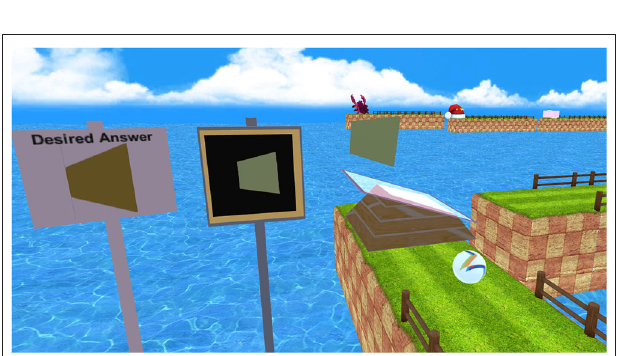
FIGURE 6 | A puzzle from the game featuring a truncated square pyramid.